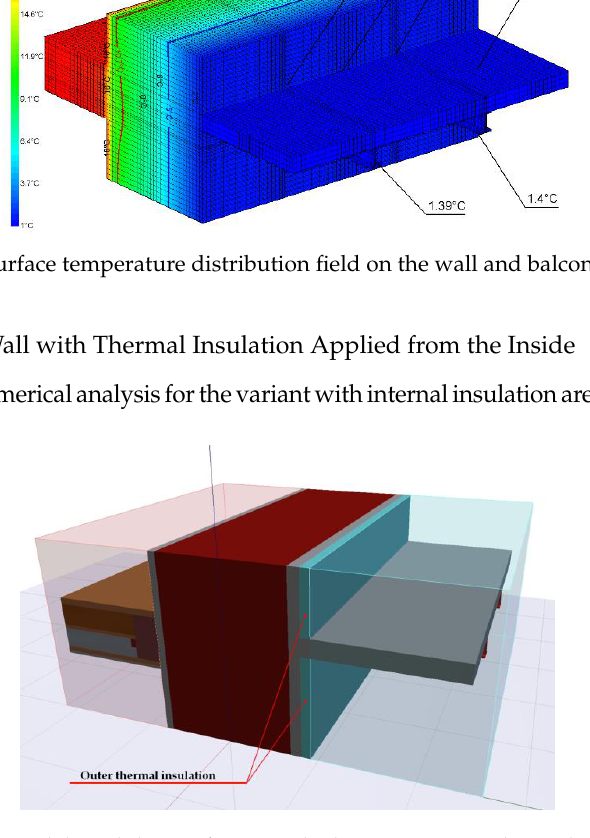
Figure 23. Geometric model—solid view from inside the room. Outer thermal insulation is marked with arrows.